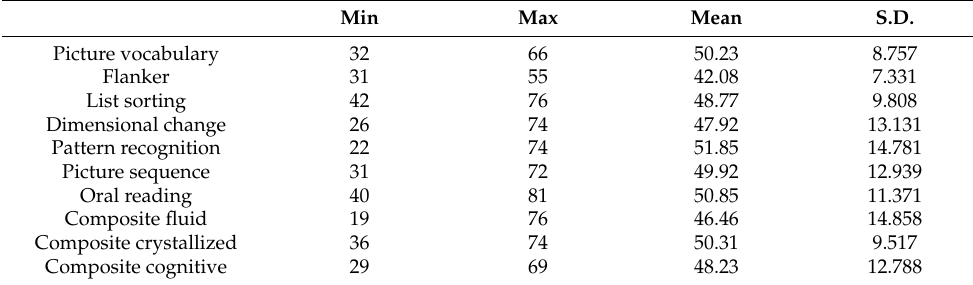
Figure 1. Box plot demonstrating the T-scores for all the tests in the cognitive battery of the NIH toolbox. Note that the Flanker test had the lowest scores. The data display shows the mean (white- filled squares), standard deviation (cyan-filled boxes), and individual data (yellow-filled circles). Table 1. T-scores for all the tests in the NIH toolbox including composite